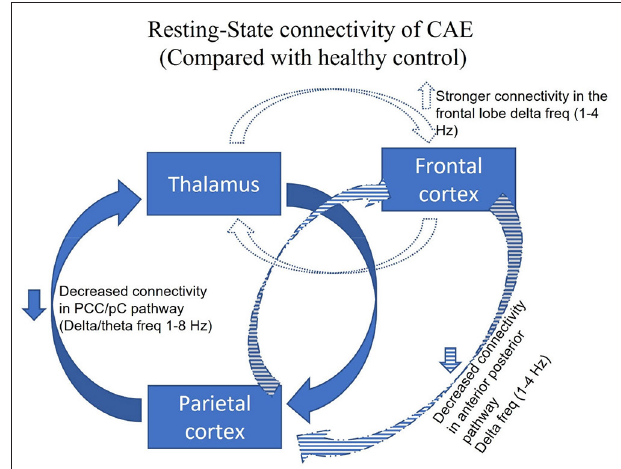
FIGURE 1 | Adapted with permission from Tenney et al. (47). Figure showing the resting-state connectivity in CAE, without 3Hz GSWDs, compared with the healthy control. The three major brain regions have been identified as responsible for the generalization of the childhood absence seizures (thalamus, frontal cortex, parietal cortex). Given all the data from Wu and colleagues, compared with the healthy control group, strong connectivity in the frontal lobe at 1–4Hz (blue dotted) and a weakened connectivity in the anterior-posterior pathway was noted within the delta band 1–4Hz (blue stripped). In the low-frequency band at 1–8Hz (blue solid), the effective network activity involving the precuneus and posterior cingulate cortex (PCC/pC) was significantly decreased in patients with CAE